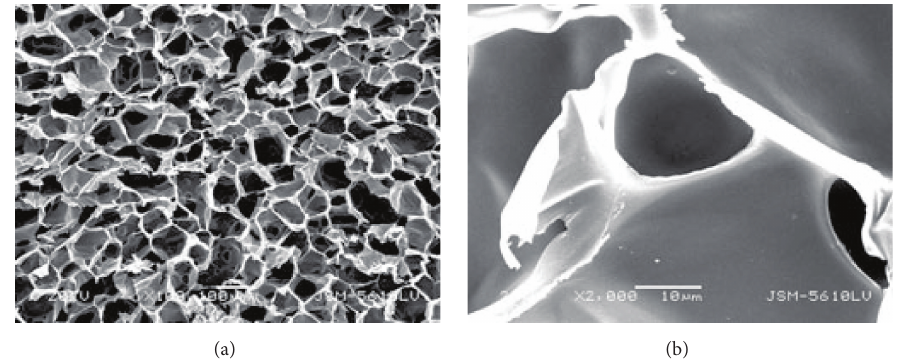
Figure 7: SEM images of the cross section of Lact-CTS-2 scaffolds.